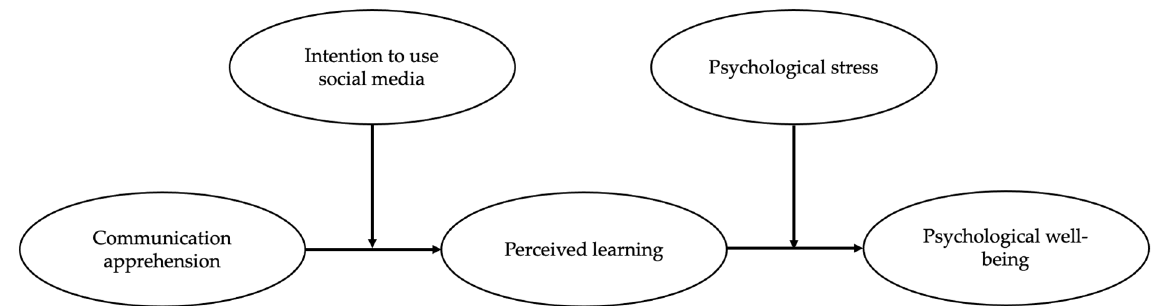
Figure 1. Hypothesized Research Model.